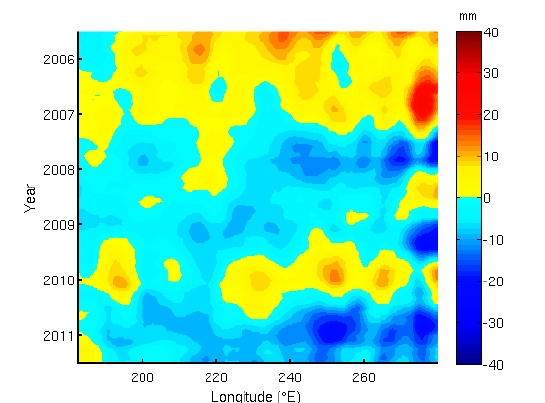
Fig. 8. Longitude/time diagram of the north Pacific ocean (0-60°N) mass sea level data based on the difference between altimetry- based sea level data and Argo steric data (down to 1500 m) over 2005-2011. Units: